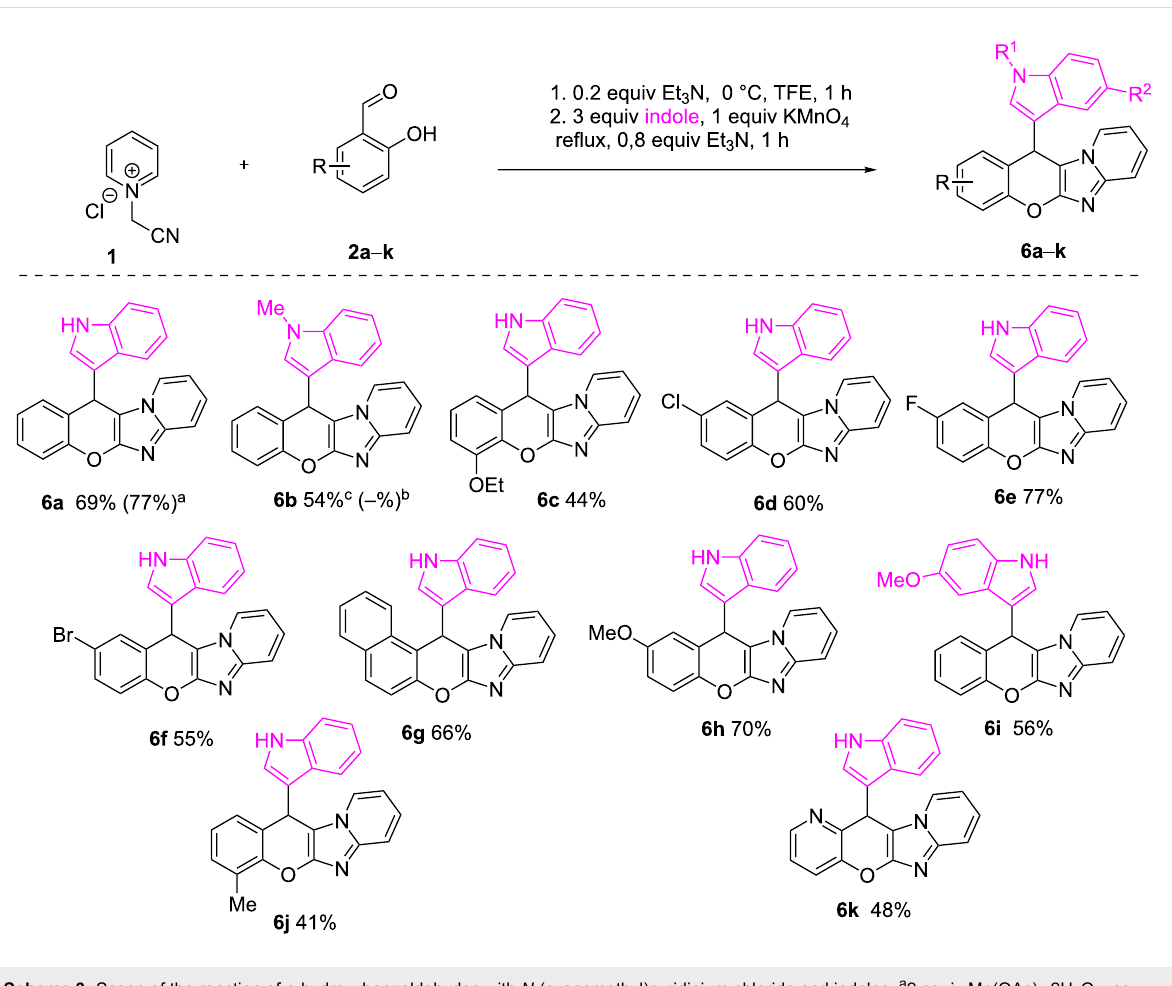
Scheme 3: Scope of the reaction of o -hydroxybenzaldehydes with N -(cyanomethyl)pyridinium chloride and indoles. a 2 equiv Mn(OAc) 3 ·2H 2 O was used as an oxidant at step 2; b isolated as inseparable mixture with 4 ; c step 2 performed at 0 °C for 5